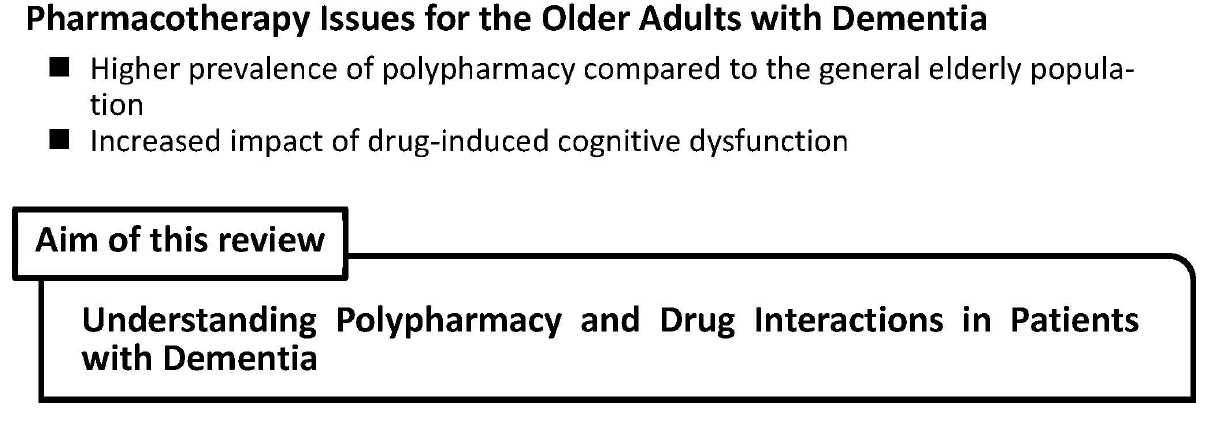
Figure 1. Aim of this review.